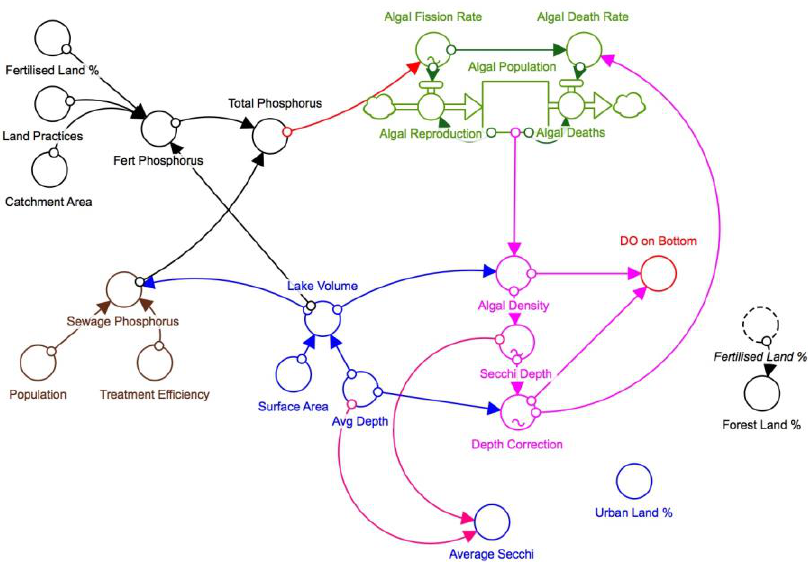
Figure 11. Lake Ellerslie Dynamic Systems Model.